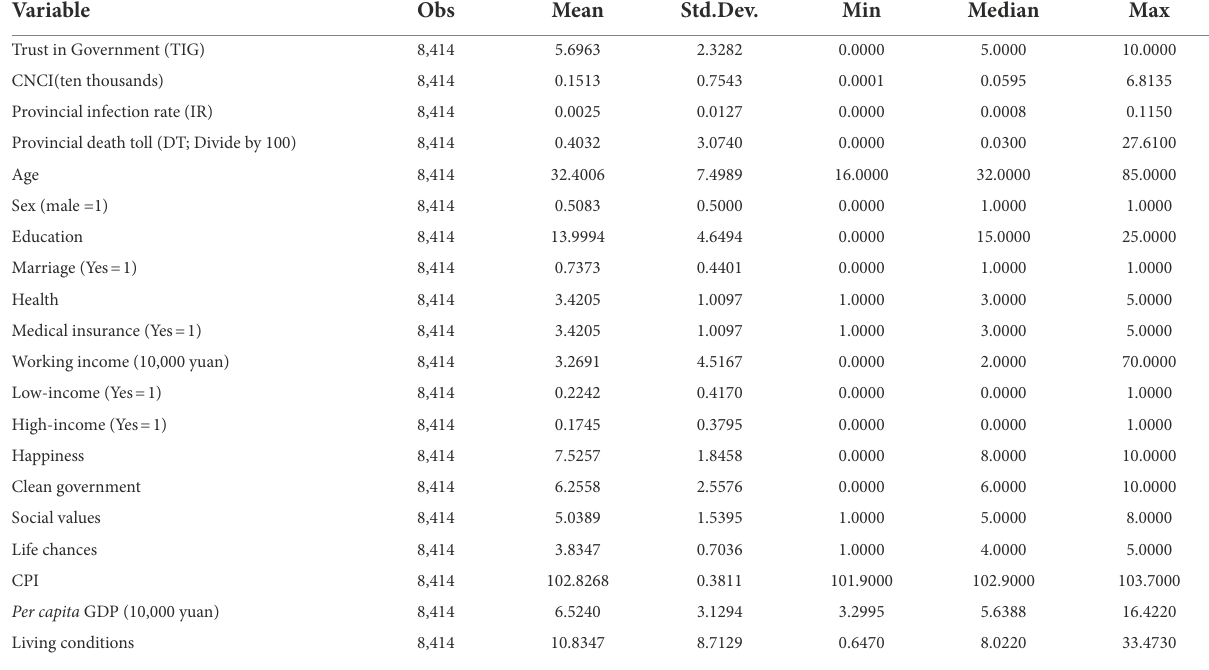
TABLE 2 Descriptive statistics of the